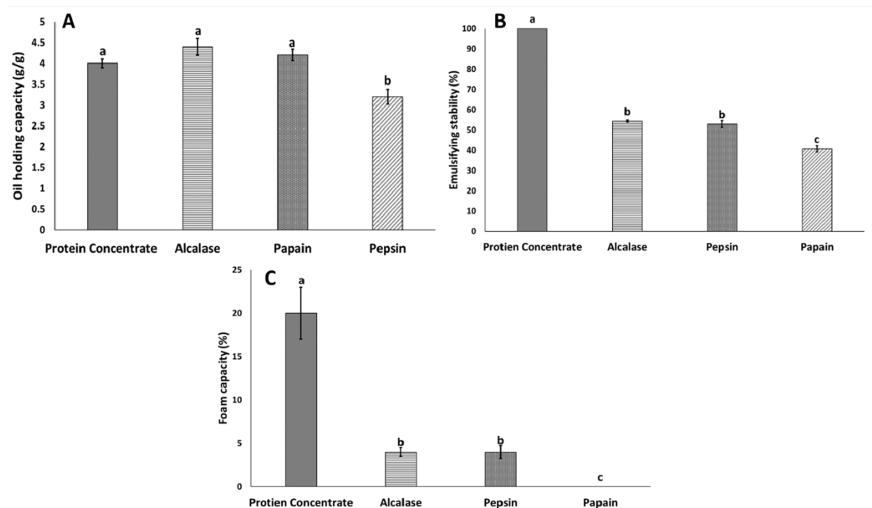
Figure 1. Functional properties of black soldier flies (BSF) protein concentrate and BSF hydrolysates. ( A ) Oil holding capacity; ( B ) emulsifying stability (ES); ( C ) foam capacity. Values with different letters are significantly different ( p < 0.05). Table 2. Amino acid composition of BSF intact protein, protein isolate and hydrolysates 1 .